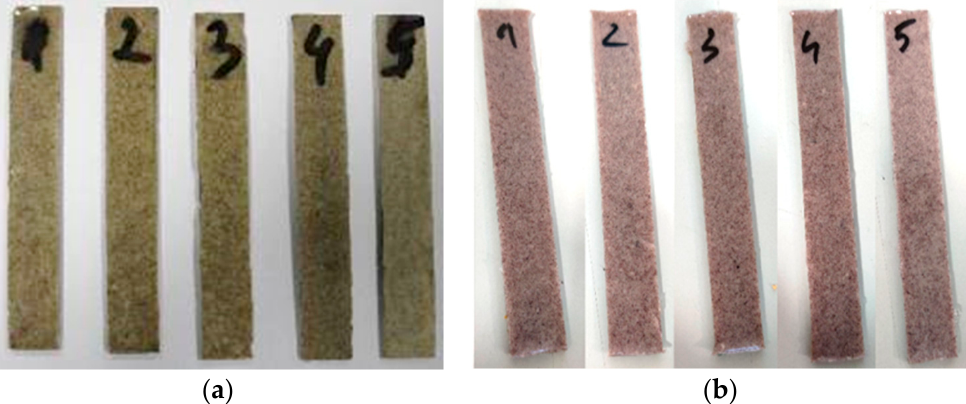
Figure 20. Specimens containing ( a ) MUF-DCPD and ( b ) PUF-ENB systems and Grubbs catalyst fabricated by method 6.